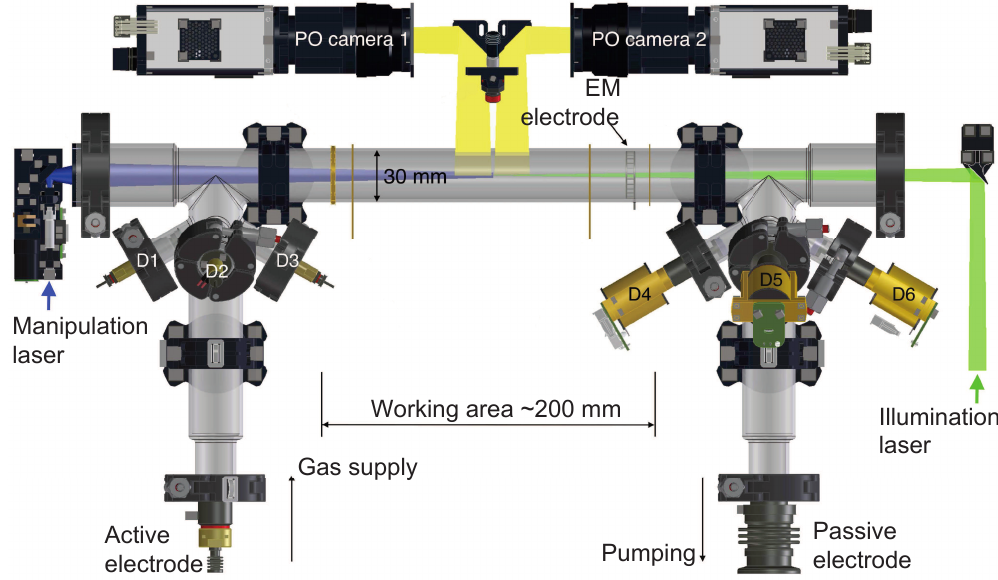
Figure 1. Schematic of the heart of the PK-4 Laboratory. An active and a passive electrode produce a DC plasma inside the glass tube with 30 mm diameter. Six microparticle dispensers (D1–D6) are mounted on the two side tubes. Once injected, the microparticles are transported into the working area with a length of approximately 200 mm in the middle of the plasma chamber. There, they are illuminated by a laser sheet and observed by the two particle observation (PO) cameras. The fields of view (FoV) of the two cameras overlap horizontally by approximately 1.36 mm (not shown in the figure), and are shifted vertically by approximately 0.14 mm. The cameras can be moved along and perpendicular to the tube axis. Reprinted from Pustylnik et al., Rev. Sci. Instr. 87, 093505 (2016) [1], with the permission of AIP